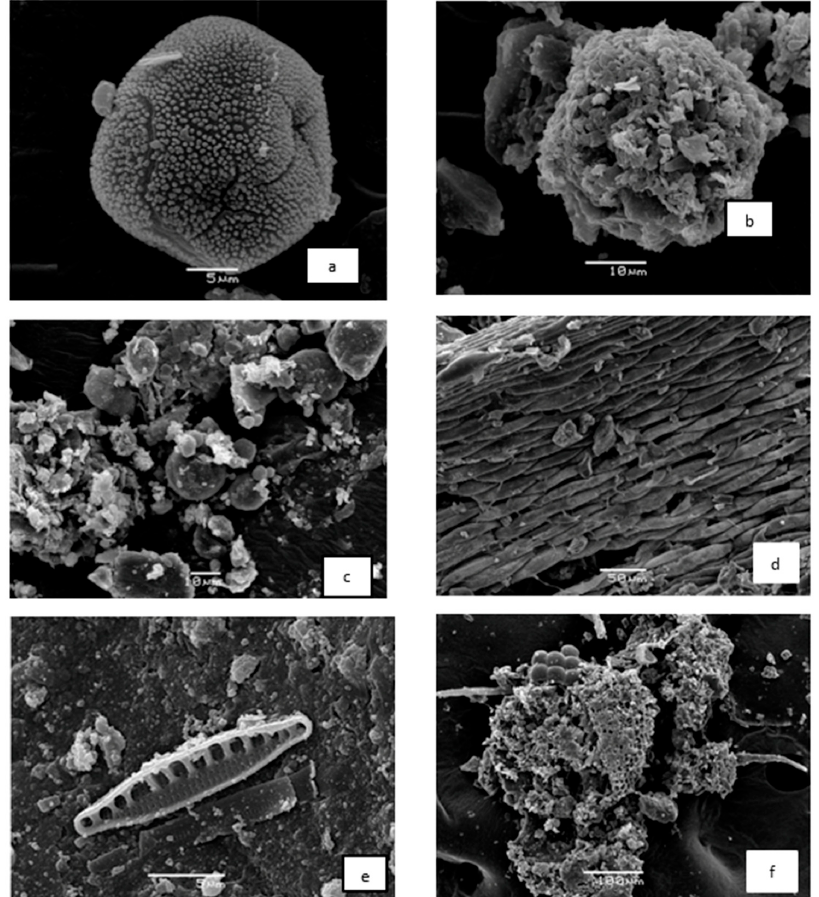
Figure 2. Atmospheric microparticles of biological origin: ( a )—pollen grains; ( b , c )—shell amoebas; ( d )—insect tissue remains; ( e )—diatoms; ( f )—perforated plant tissue. SAM JSM-6380 LA. The scale is 5 μ m ( a , e ), 10 μ m ( b , c ), 50 μ m ( d ) and 100 μ m ( f ).